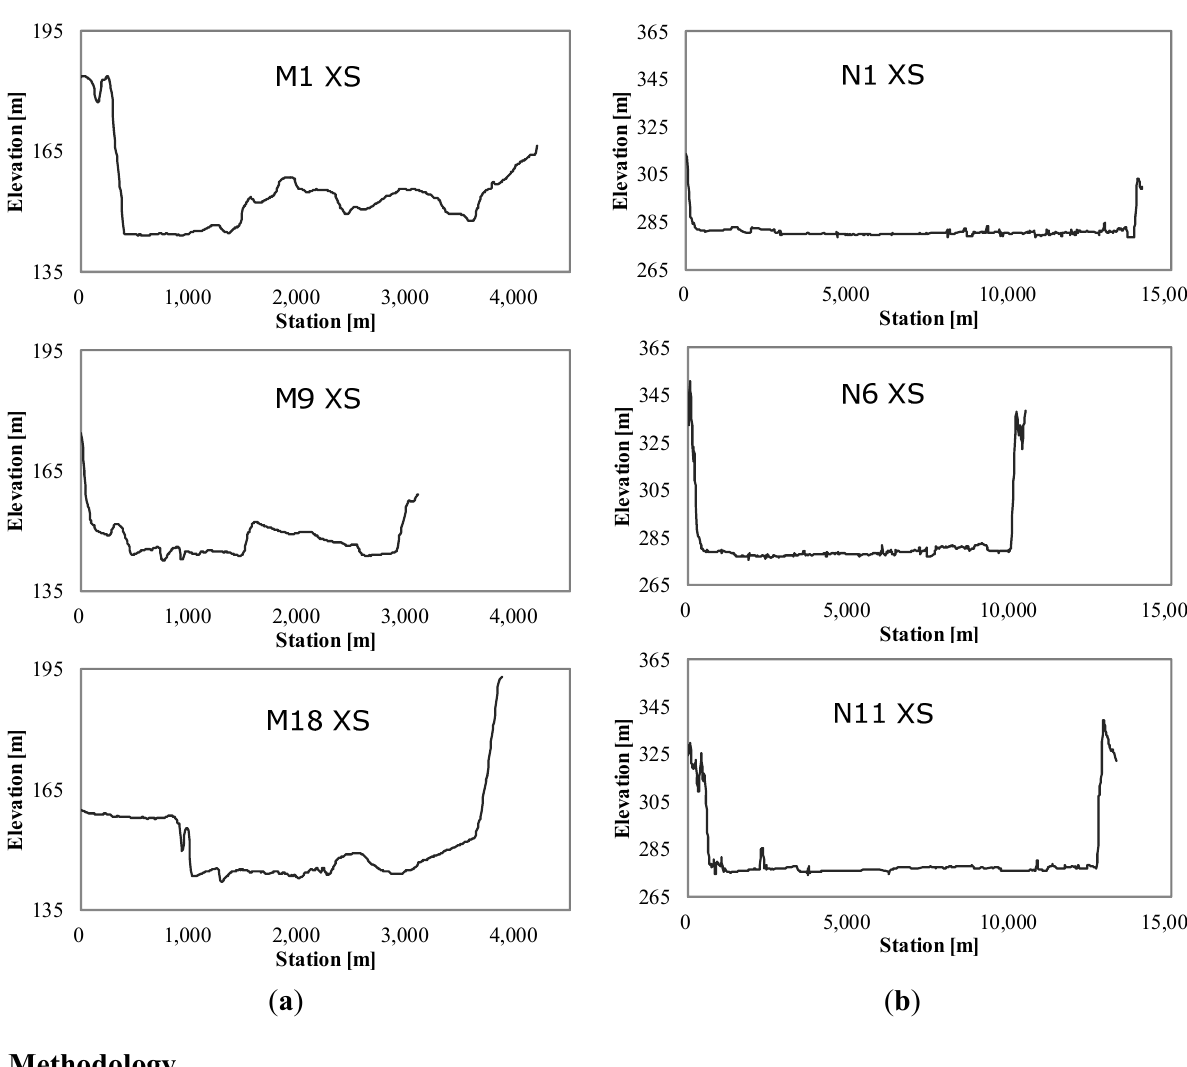
Figure 2. Geometric shape of cross-sections for study reaches. ( a ) Montezuma reach; ( b ) Nebraska